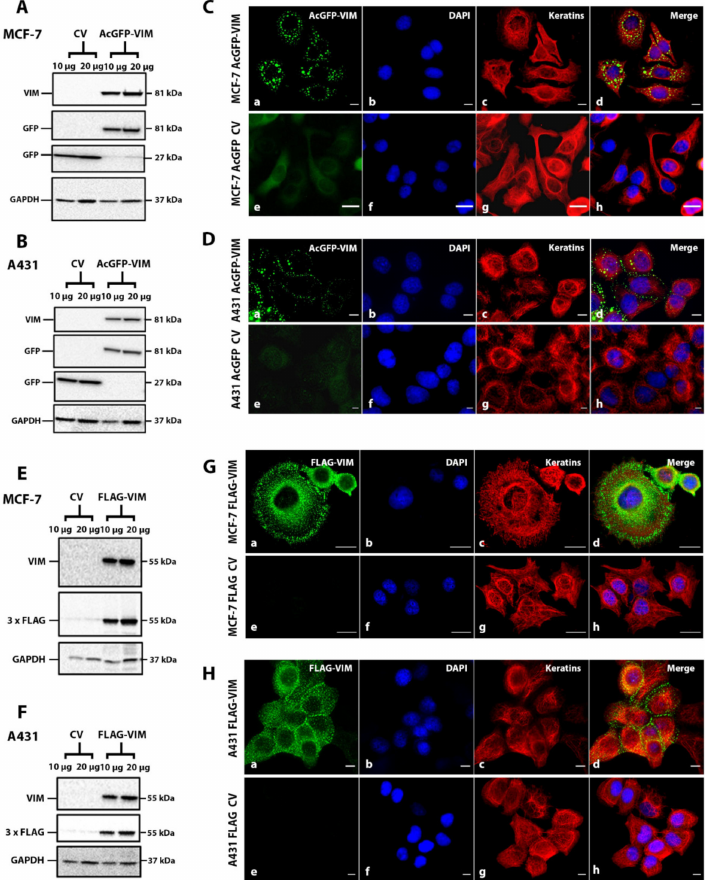
Figure 3. Ectopic expression of N-terminally tagged vimentin in MCF-7 and A431 cells. Healthy growing cells ( A , E ) MCF-7 and ( B , F ) A431 were transduced separately with ( A , B ) control vector (CV) AcGFP and AcGFP-VIM; ( E , F ) control vector (CV) FLAG and FLAG-VIM, respectively. Total protein extract, 10 and 20 µ g, from each transduced cell line was loaded onto SDS PAGE gels, transferred onto nitrocellulose, and probed with mouse anti-vimentin antibody, or rabbit anti-FLAG antibody to confirm the transduction efficiency. GAPDH was used as the loading control. Molecular weights of the gel bands are given on the right-hand side of the blots. Relevant bands were cropped from different blots and regrouped together. Original blots are shown in Supplementary Figures S3 and S4. ( C , G ) MCF-7 and ( D , H ) A431 cells expressing ( C , D ) AcGFP and AcGFP-VIM and ( G , H ) FLAG and FLAG-VIM, respectively, were grown on collagen coated glass coverslips and fixed with acetone: methanol (1:1). The cells in ( G , H ) were incubated with rabbit anti-FLAG antibody and counterstained with AF-488 goat anti-rabbit secondary antibody (green). All coverslips in ( C , D , G , H ) were incubated with A45-B/B3 (keratins) and counter stained with AF-594 labelled goat anti-mouse secondary antibody (red). Nuclei were stained with DAPI in blue and overlapping of all colours is shown as ‘Merge’. Leica DM4000B Epi-fluorescence microscope was used for visualisation and DFC350 camera was used for image recording (scale bar = 20 µ